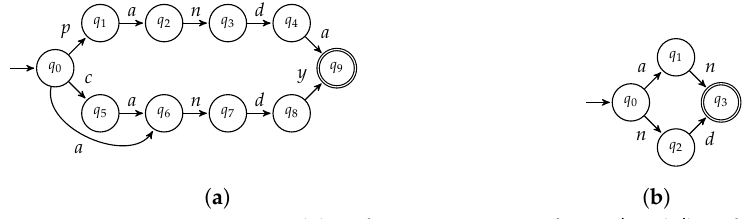
Figure 11. ( a ) A , L ( A ) = { abc , abd , ef g } ( b ) A (cid:48) , L ( A (cid:48) ) = { ab , f g } .